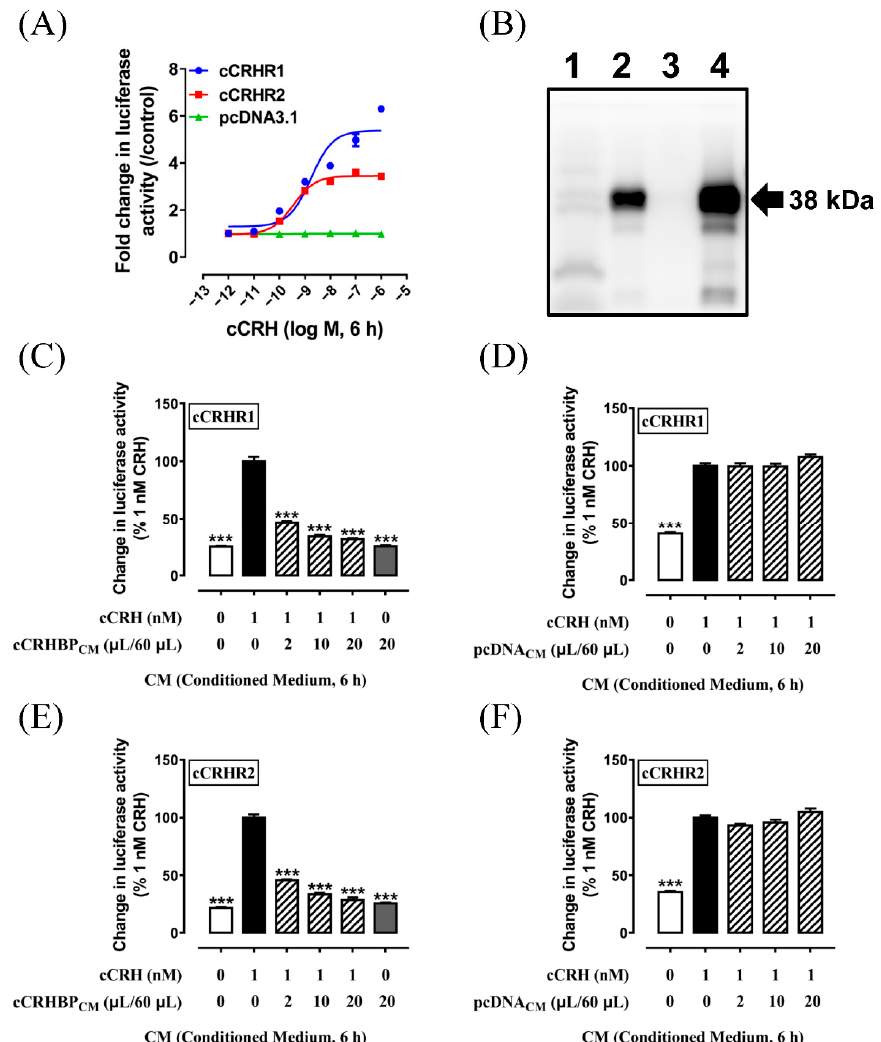
Figure 5. ( A ) Effect of cCRH on the signaling of cCRHR1 and cCRHR2 expressed in CHO cells. Each data point represents the mean ± SEM of triplicates ( n = 3). ( B ) Detection of chicken His-tagged CRHBP by Western blot. Lane 1: cell lysate sample; Lane 2: cCRHBP conditioned medium before ultrafiltration; Lane 3: cCRHBP conditioned medium flow via ultrafiltration; Lane 4: cCRHBP conditioned medium after ultrafiltration. ( C , E ) Effect of cCRHBP conditional medium (cCRHBP CM ) on the signaling of cCRHR1 ( C ) and cCRHR2 ( E ) activated by cCRH. ( D , F ) Effect of control conditional medium (pcDNA CM ) on the signaling of cCRHR1 ( D ) and cCRHR2 ( F ) activated by cCRH. The luciferase activities were expressed as a percentage of the CRH treatment group. Each value represents the means ± SEM of four replicates ( n = 4). ***, p < 0.001 vs. 1 nM CRH treatment